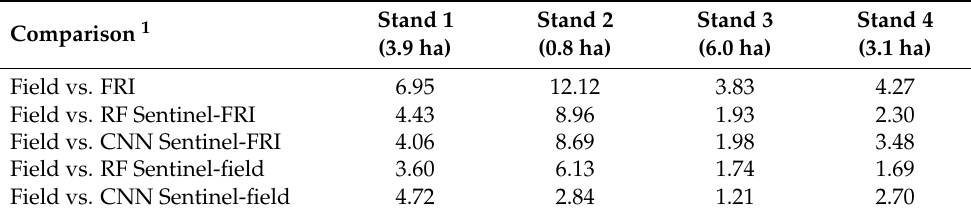
Table 3. Euclidian distances between field observations and FRI or model predictions for four stands in the Haliburton Forest “Megaplot” in south-central Ontario. Tree communities in the field